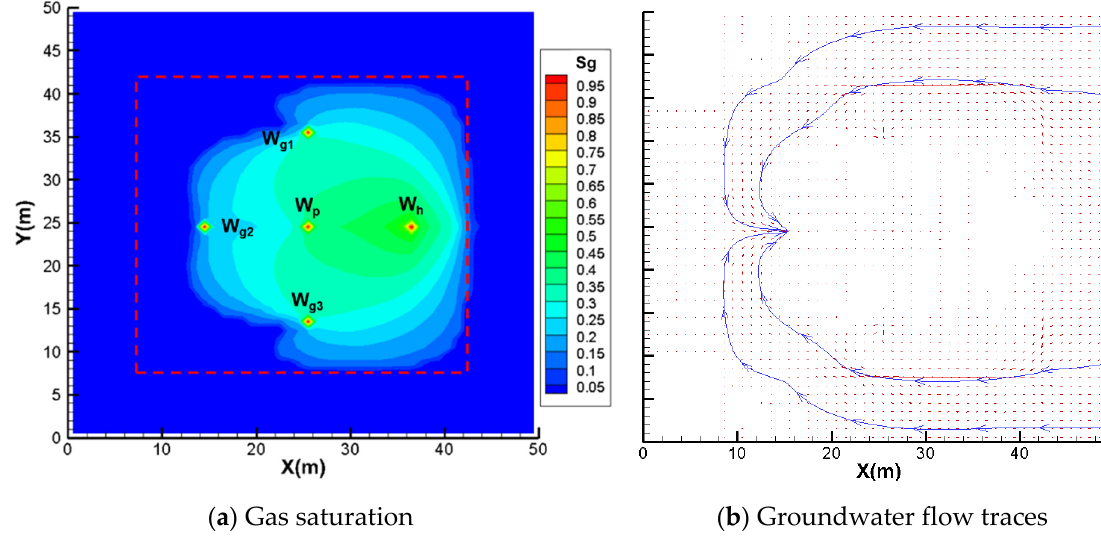
Figure 7. Gas saturation nephogram and groundwater flow traces in the gas flooding pressure of 5 MPa.